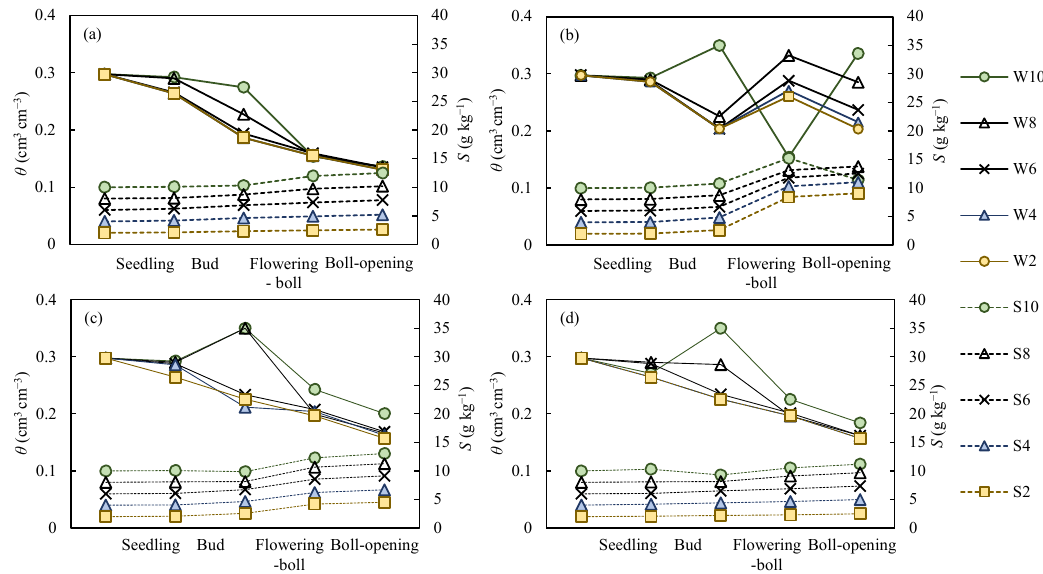
Figure 10. Dynamic thresholds of soil water content and salinity in the root zone for different scenarios: ( a ) W 0 = 0.85 θ fc , M = 200 mm, K = 0 g L − 1 ; ( b ) W 0 = 0.85 θ fc , M = 550 mm, K = 9 g L − 1 ; ( c ) W 0 = 0.85 θ fc , M = 400 mm, K = 3 g L − 1 ; ( d ) W 0 = 0.85 θ fc , M = 400 mm, K = 0 g L − 1 ; W 2, W 4, W 6, W 8 and W 10